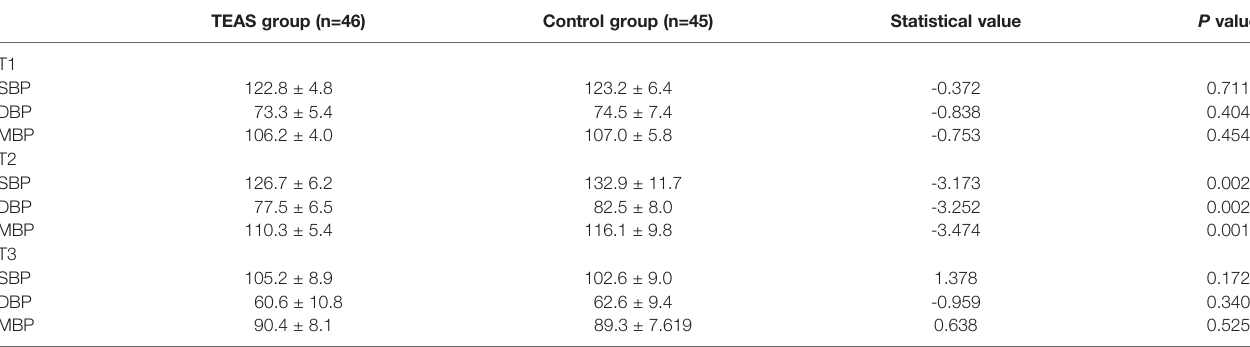
TABLE 2 | The blood pressure at each time point.